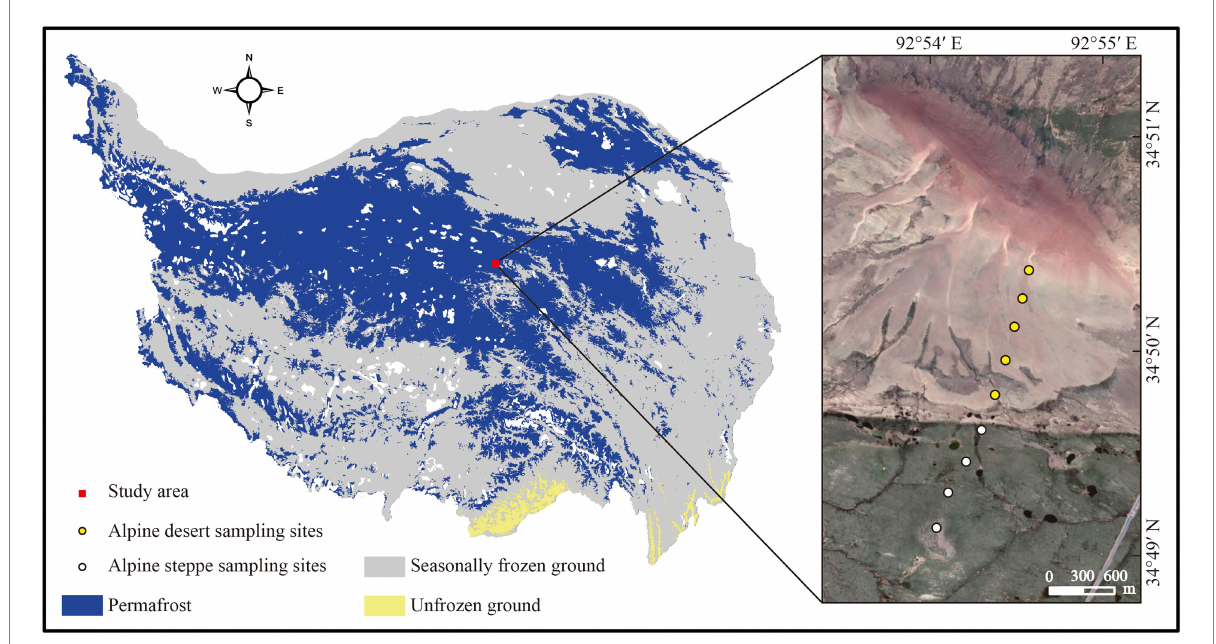
FIGURE 1 Sampling sites and distribution of permafrost on the Tibetan plateau. The map was created by the authors using ArcMap 10.4 (Environmental Systems Research Institute, Inc., Redlands, CA, USA; Zou et al., 2017;